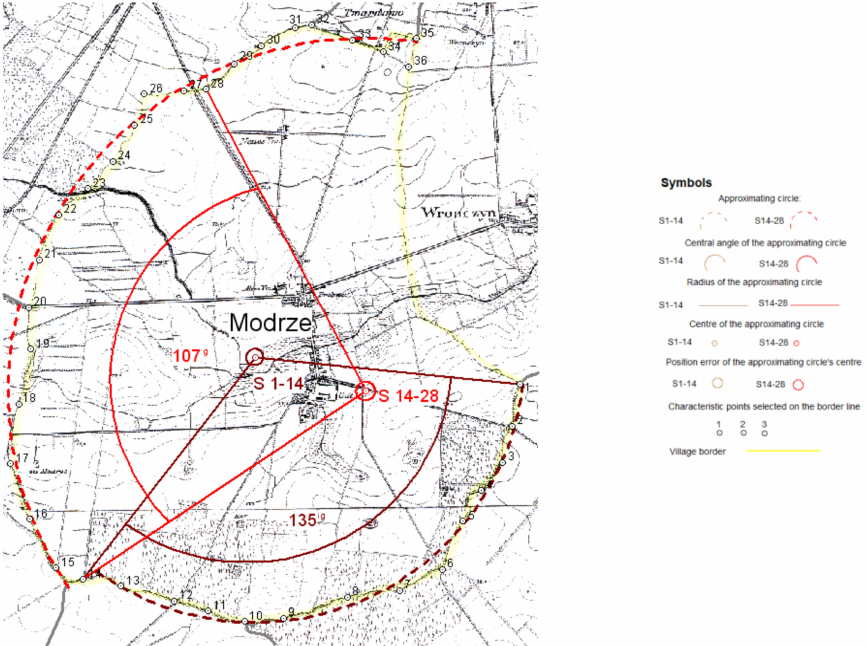
Figure 17. Modrze. Course, position and error of the approximating circle: S 1—14–approximation of points 1—14; S 14—28–approximation of points 14—28. Scale